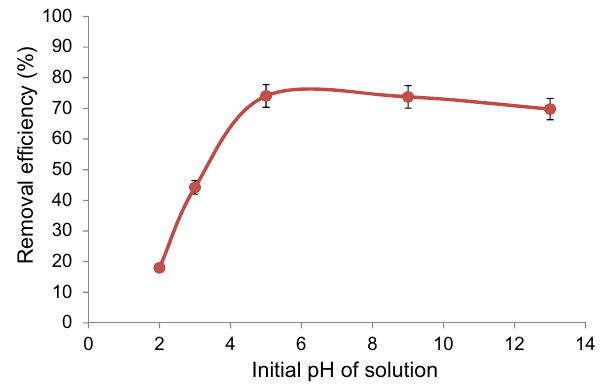
Fig. 2 Effect of pH of solution on the adsorption of Cd(II) ion onto UMSFS biomass